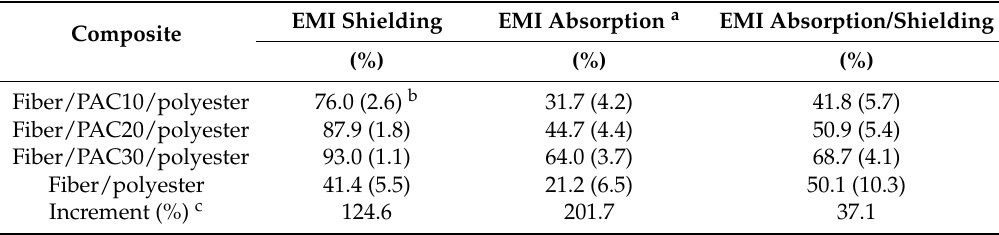
Table 3. EMI shielding and absorption of the four